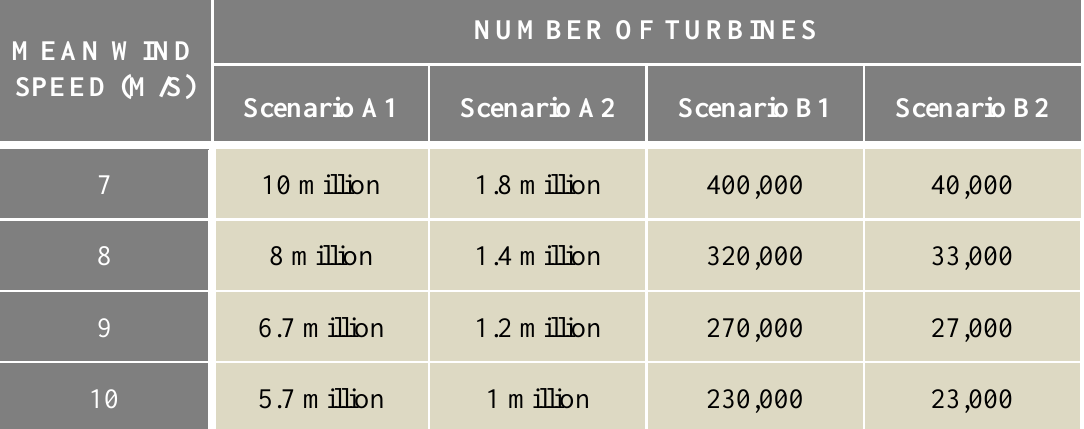
Table 3. Number of 1.5 MW turbines required for each scenario (see Table 2 for scenario description).